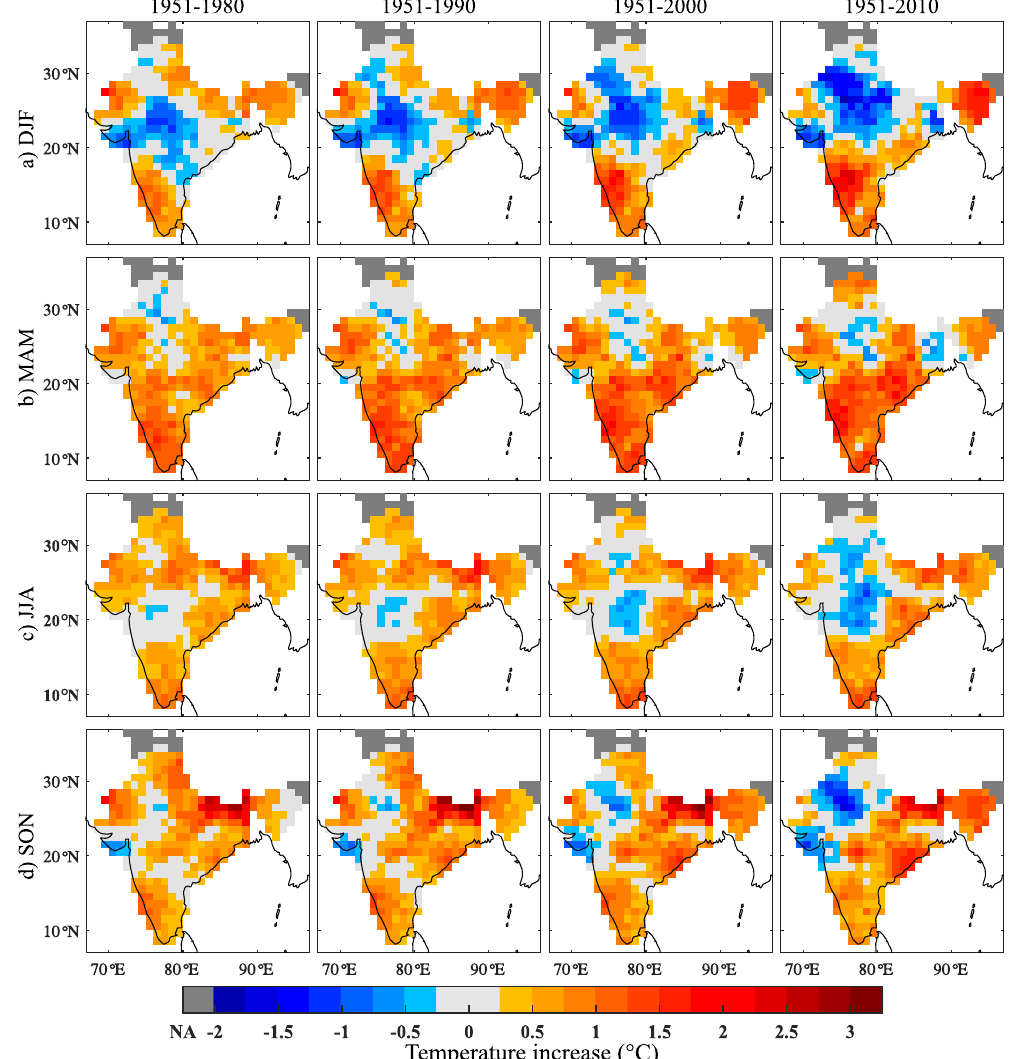
Figure 3. Spatial evolution of Ensemble Empirical Mode Decomposition trend of seasonal DTR for ( a ) DJF, ( b ) MAM, ( c ) JJA and ( d ) SON. Each sub panel has four time windows 1) 1951–1980, 2) 1951–1990, 3) 1951–2000 and 4) 1951–2010. Grids with inconsistent data are shown in dark grey colour (extreme left of colour bar), which is represented as NA (Not Analysed). ± 0.25 °C range is assigned a light grey colour for easy distinction of positive and negative trends. The maps were generated using the software MATLAB (version 2014b) http://